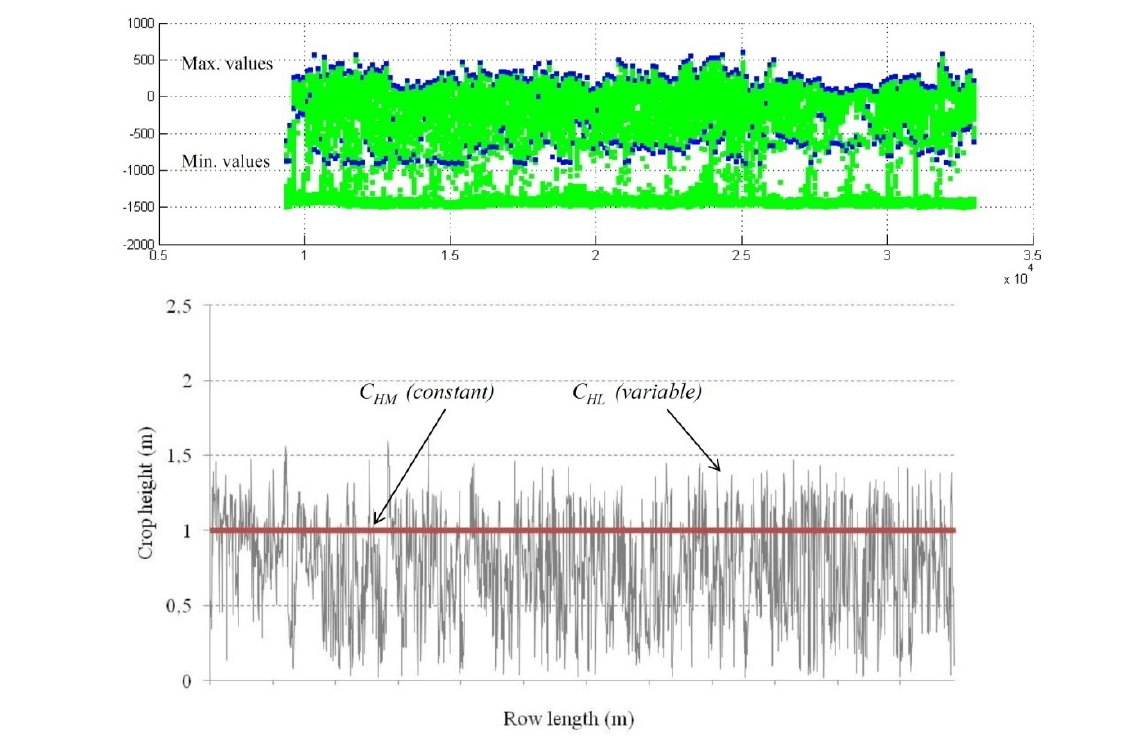
Figure 6. Simulated crop profile (top) obtained with laser sensor. Differences between max and min height on a single crop slice are used to measure canopy height. LWA is calculated according crop height variation along the row and compared with manual measurements